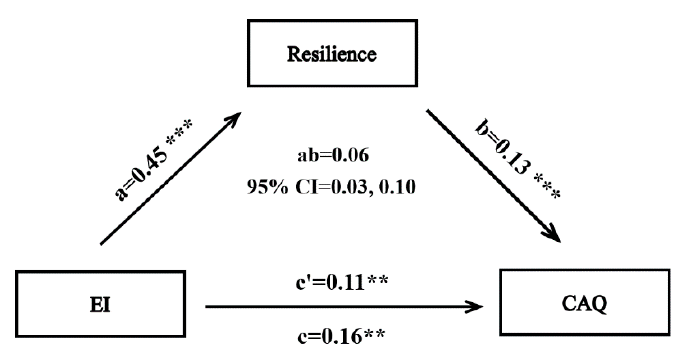
Figure 1. Mediation analyses. Note: Full items are listed by abbreviations. EI—emotional